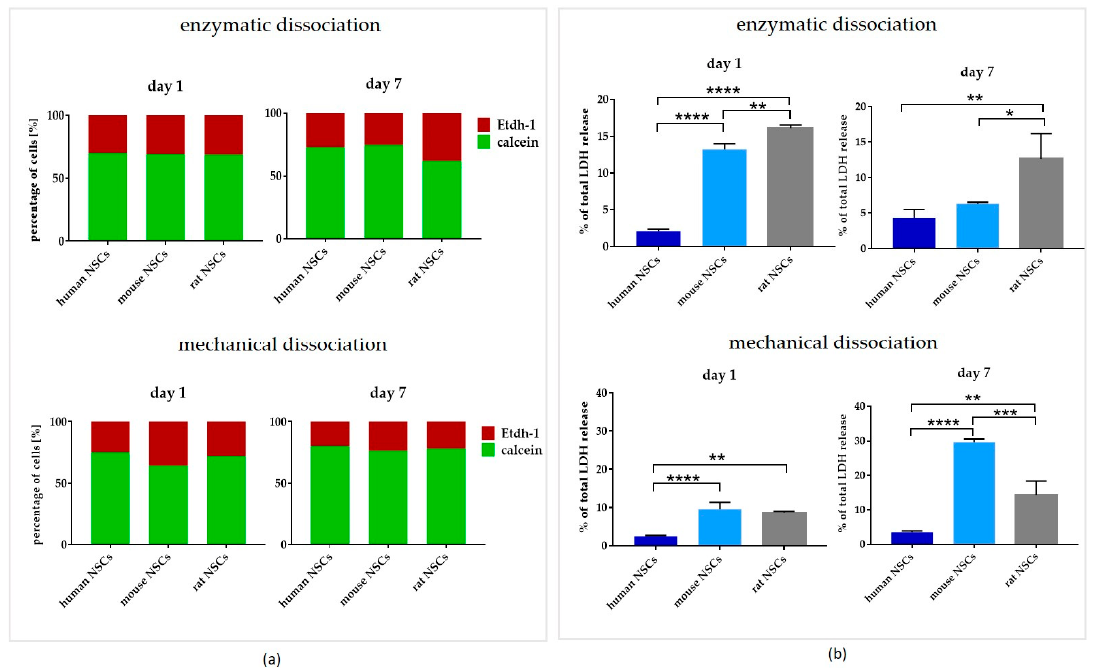
Figure 10. The influence of dissociation methods—enzymatic and mechanical—( a ) on NSCs’ calcein+ and Etdh-1+ cells’ presence on Day 1 and Day 7 of culture, and ( b ) on NSCs’ LDH release on culture Days 1 and 7. Cell culture conditions: 5% O 2 , 5% CO 2 , 37 °C, n = 3. The results of all presented experiments are expressed as mean values of three experiments ± SEM. The differences were considered statistically significant when the p -value < 0.05. Statistical significance level: * for 0.01 < p < 0.05, ** for 0.001 < p < 0.01, *** for 0.0001 < p < 0.001, and **** for p < 0.0001.